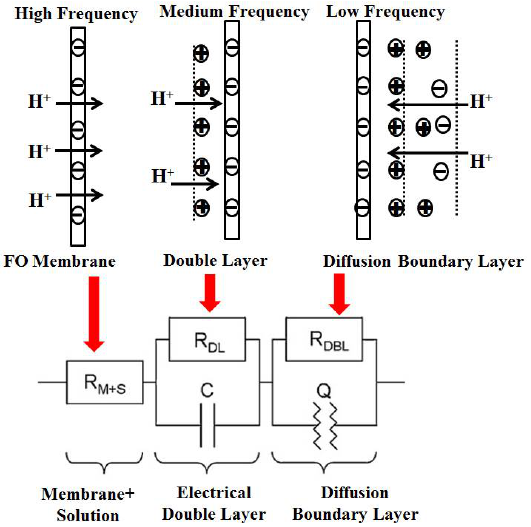
Figure 2. Partition of the membrane electrical resistance into equivalent electrical elements.